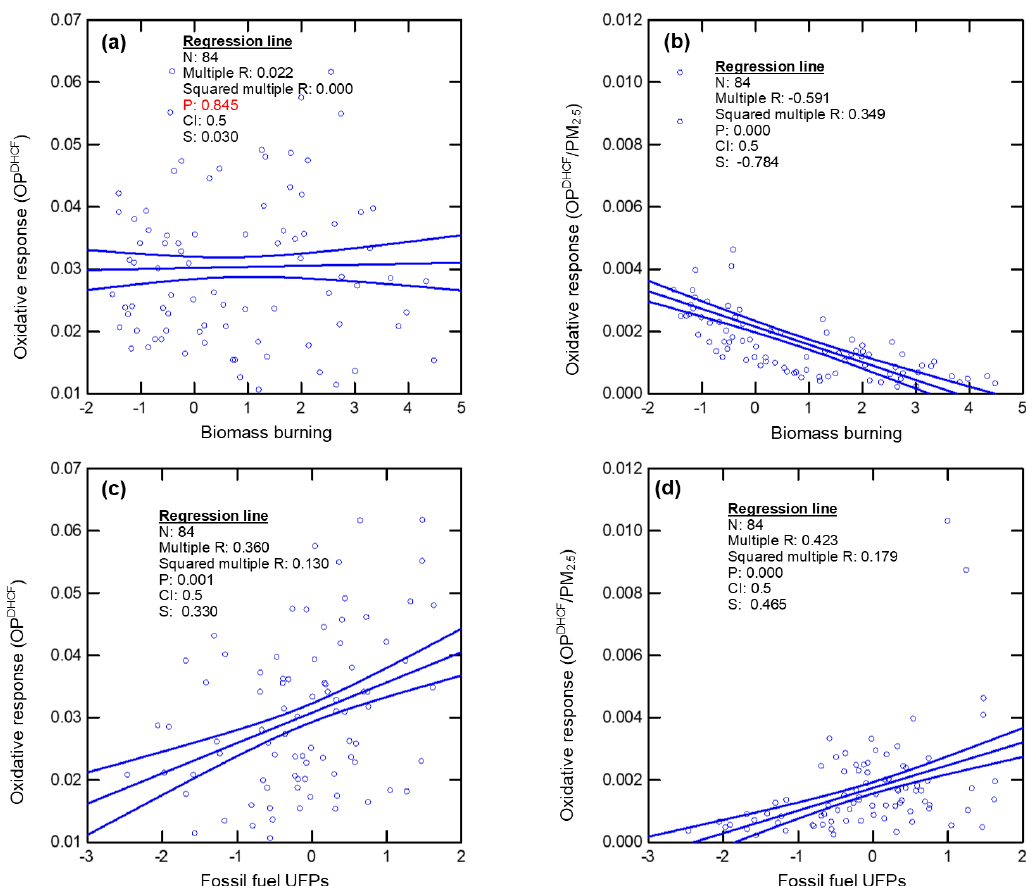
Figure 1. Linear regression of the oxidative response (both as oxidative potential, OP DHCF , panels ( a ) and ( c ), and mass-normalised-OP DHCF , panels ( b ) and ( d ) against the two major combustion aerosols in PM 1 and UFPs (biomass burning, panels ( a ) and ( b ), and fossil fuels UFPs, panels ( c ) and ( d ) Data time resolution is 2 h. Number of points (N), Pearson correlation coefficient (multiple R and squared multiple R), Bonferroni probability (P), confidence interval (CI) on the regression line, and Spearman correlation coefficient (S) are indicated.